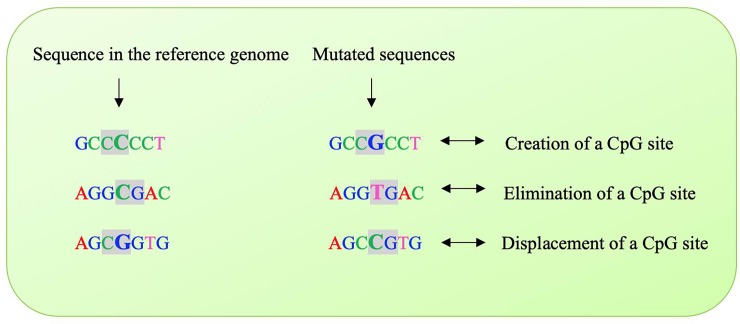
Examples of variants caused by meSNP.The modification caused by a meSNP can create, destroy or displace a CpG site, the disruption of these sites can drastically change the methylation state. Base in bold represents a meSNP.